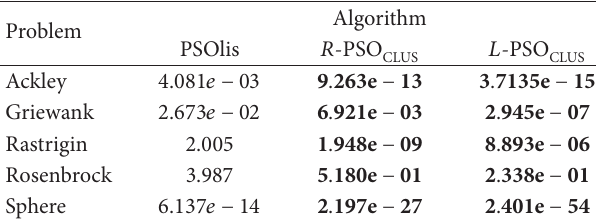
and 𝐿 -PSO CLUS CLUS